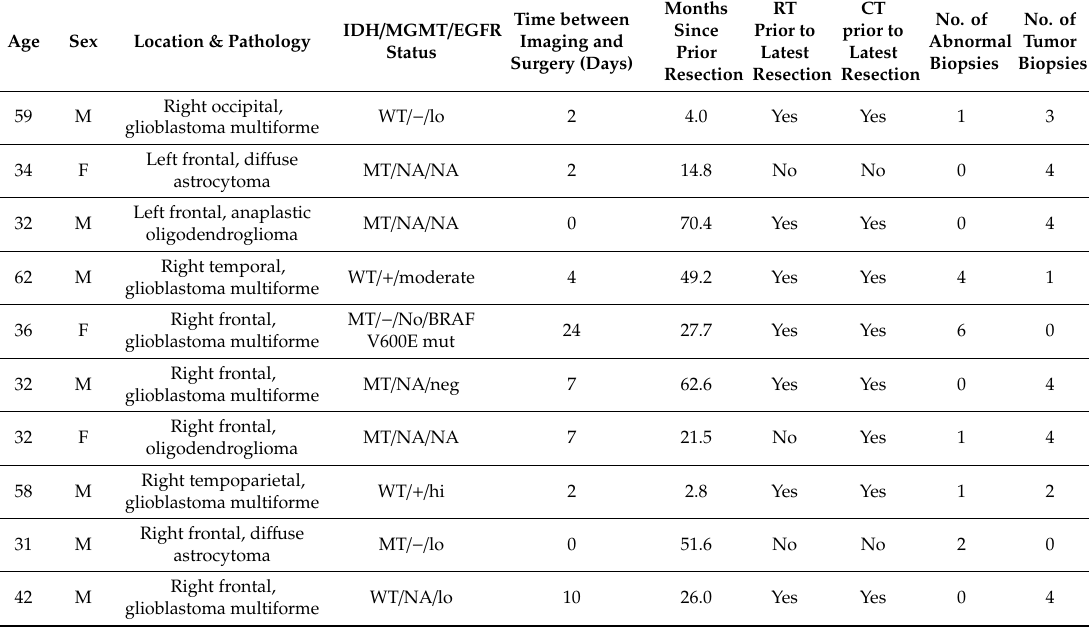
Table 1. Clinical data of the patient